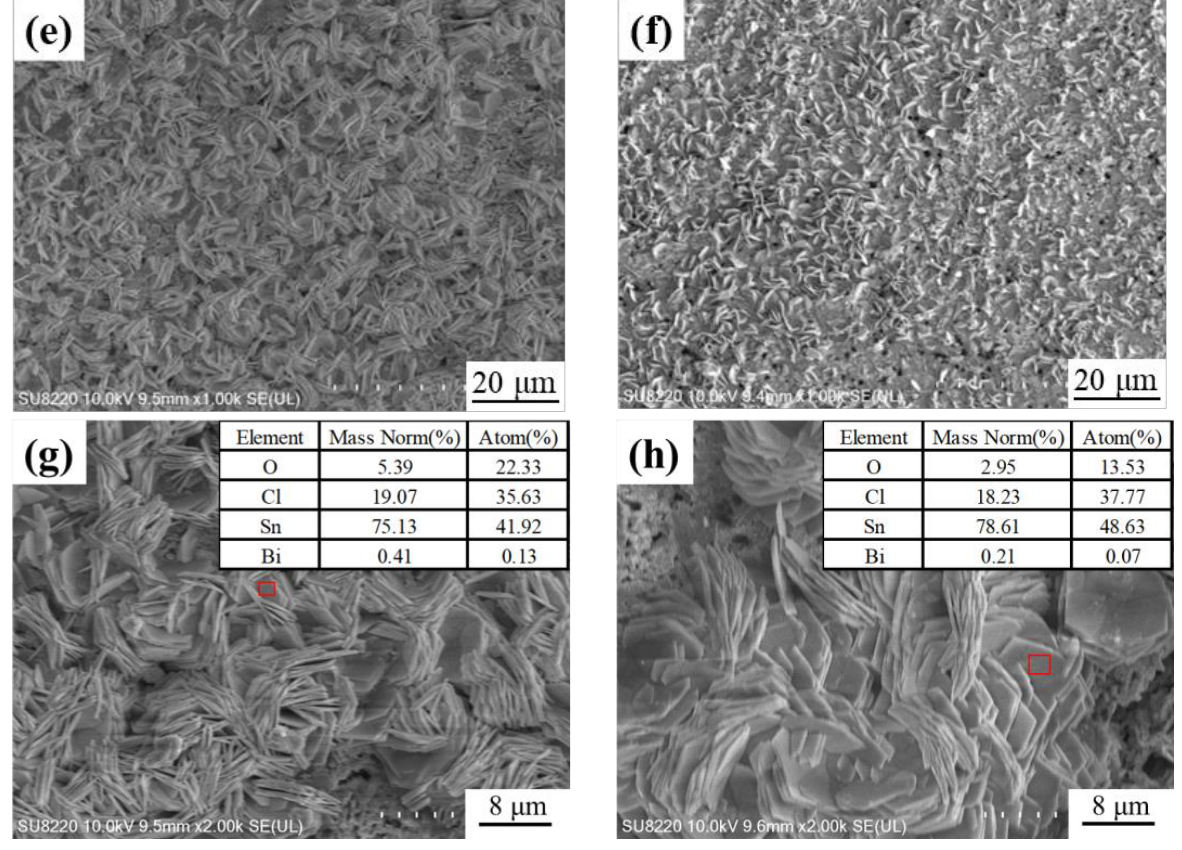
Figure 9. SEM images of corrosion morphology; ( a – f ) the morphologies of MC Sn-20Bi- q GNSs ( q = 0, 0.01, 0.02, 0.04, 0.06, 0.1wt.%); ( g , h ) EDS analysis results of MC Sn-20Bi-0.01GNSs and MC Sn-20Bi-0.02GNSs corrosion products (red frames).